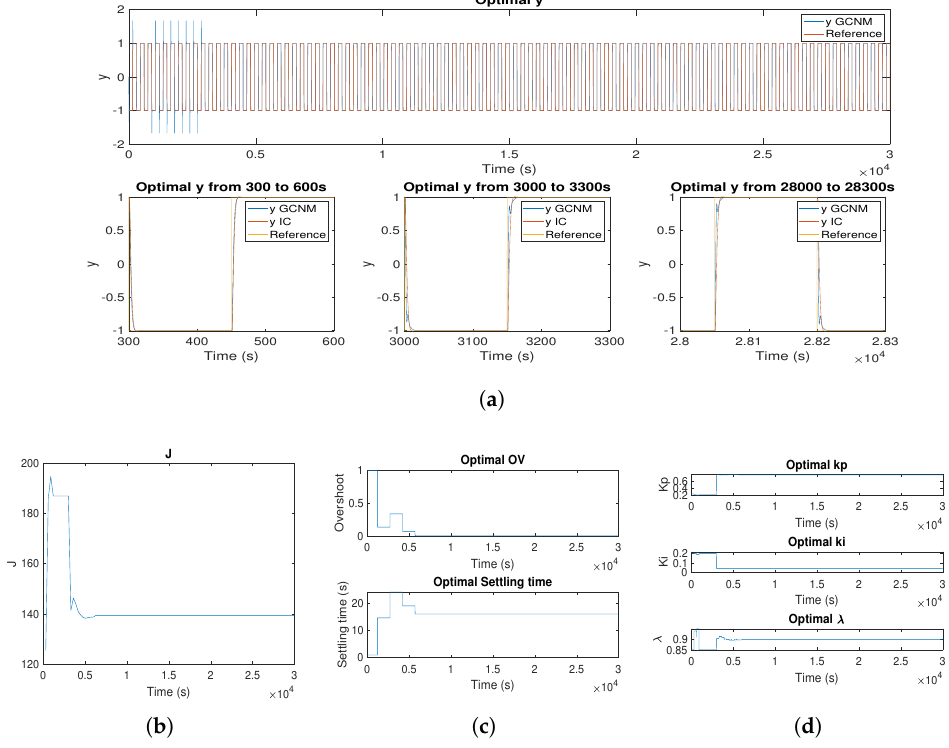
Figure 6. FOSOC controller: ( a ) time response, ( b ) cost function, ( c ) overshoot and settling time, and ( d ) FOPI gains evolution for L = 10